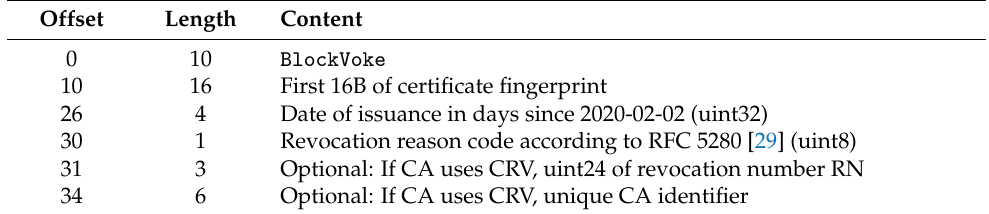
Table 1. OP_RETURN payload of a BlockVoke